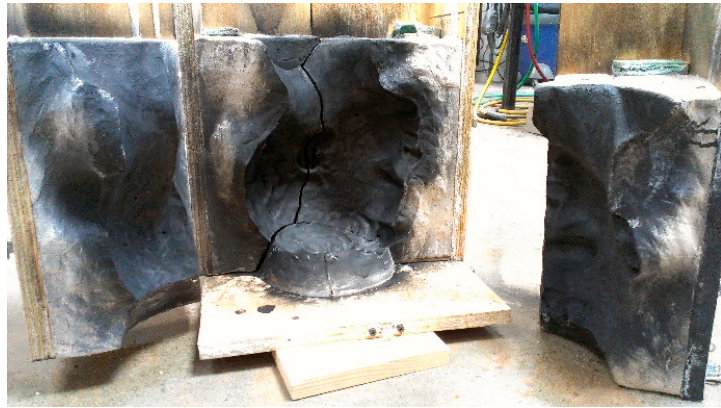
Figure 6. Hinged, 5-part plaster blow mold coated with graphite in preparation for hot glass. [Created by